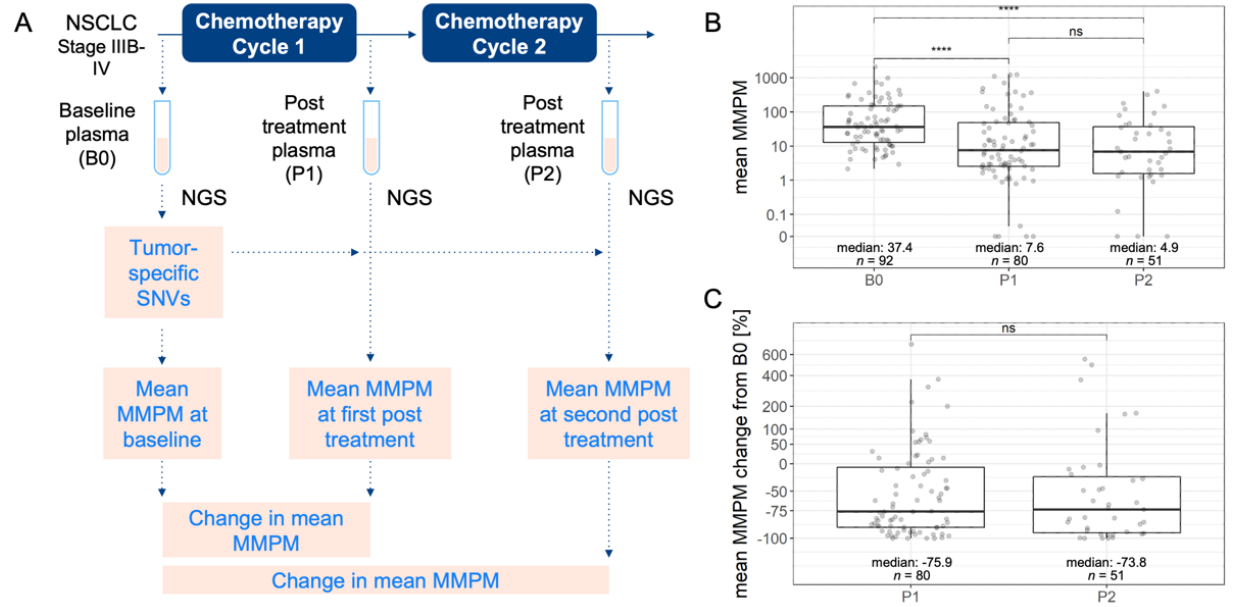
Figure 1. Study design and ctDNA level distributions. ( A ) ctDNA sequencing was performed on baseline plasma (B0) and first available plasma after one cycle of chemotherapy (P1) and first available plasma after two cycles of chemotherapy (P2). ctDNA levels were measured as mean mutant molecules per milliliter (MMPM). ( B ) Distribution of ctDNA levels in B0, P1, and P2 samples. ( C ) Distribution of changes in ctDNA level at P1 from B0 and P2 from B0 in matched samples. Center line indicates the median value. **** Wilcoxon p ≤ 0.0001. ns: not significant, Wilcoxon p > 0.05.